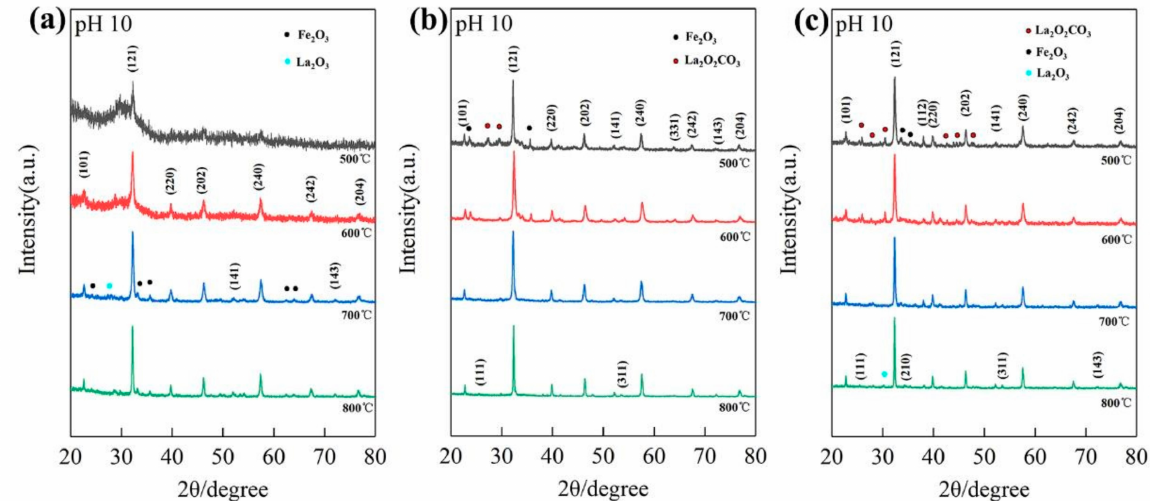
Figure 4. The XRD patterns of samples (La/Fe 3:7) precipitated by ammonia ( a ) and KOH solution ( b ), and NaOH solution with the use of PVP ( c ), after calcination at different